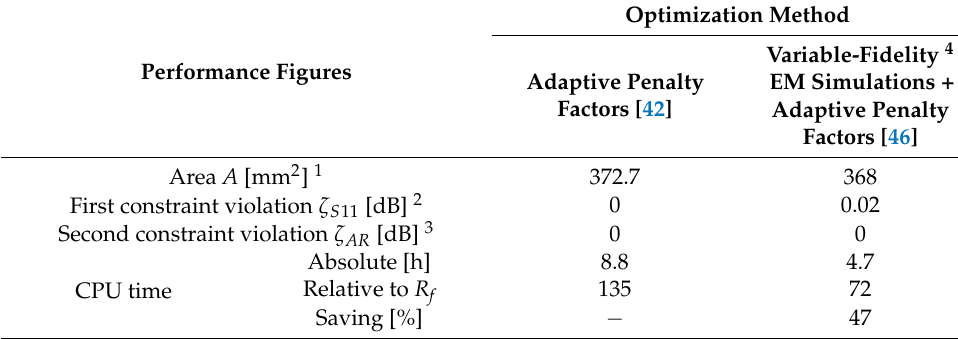
Table 6. Optimization results for antenna of Figure 25.